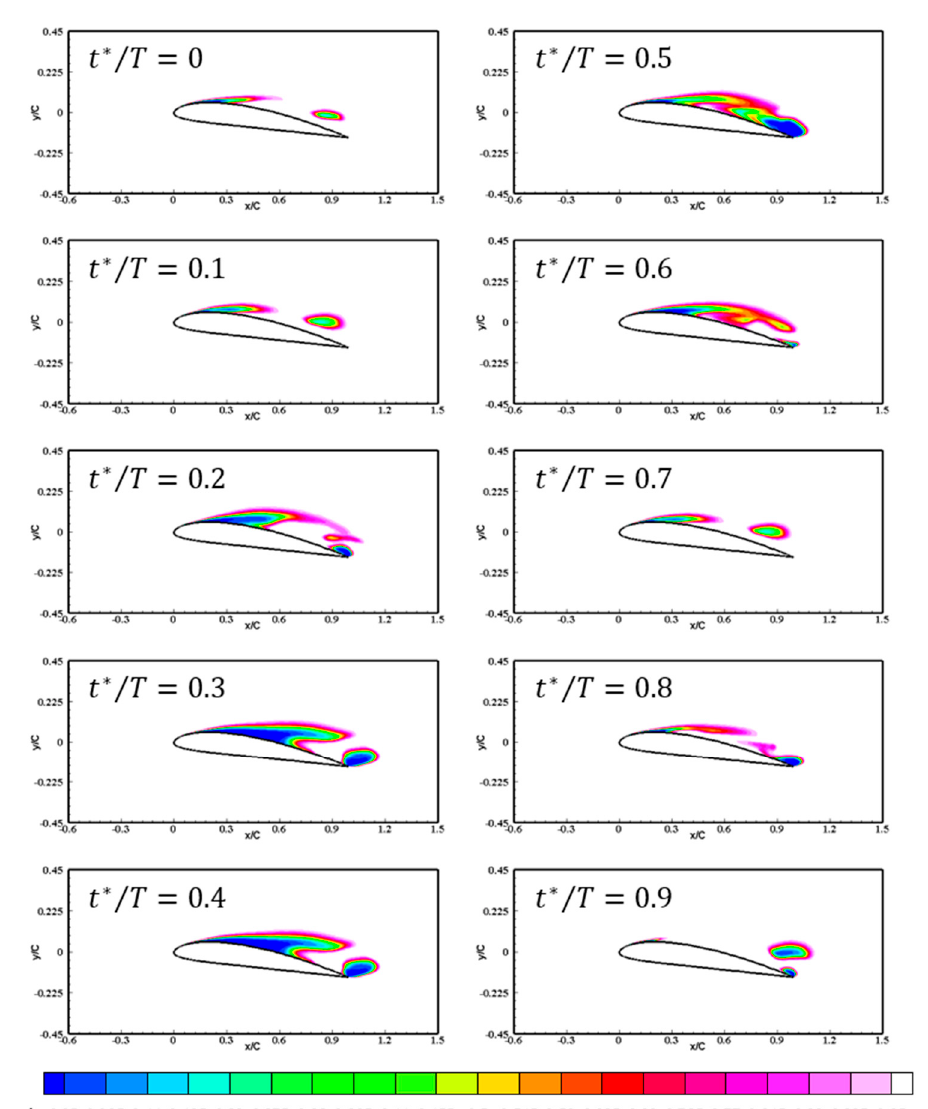
Figure 8. Time-variation of predicted liquid volume fraction in thin-layer case.